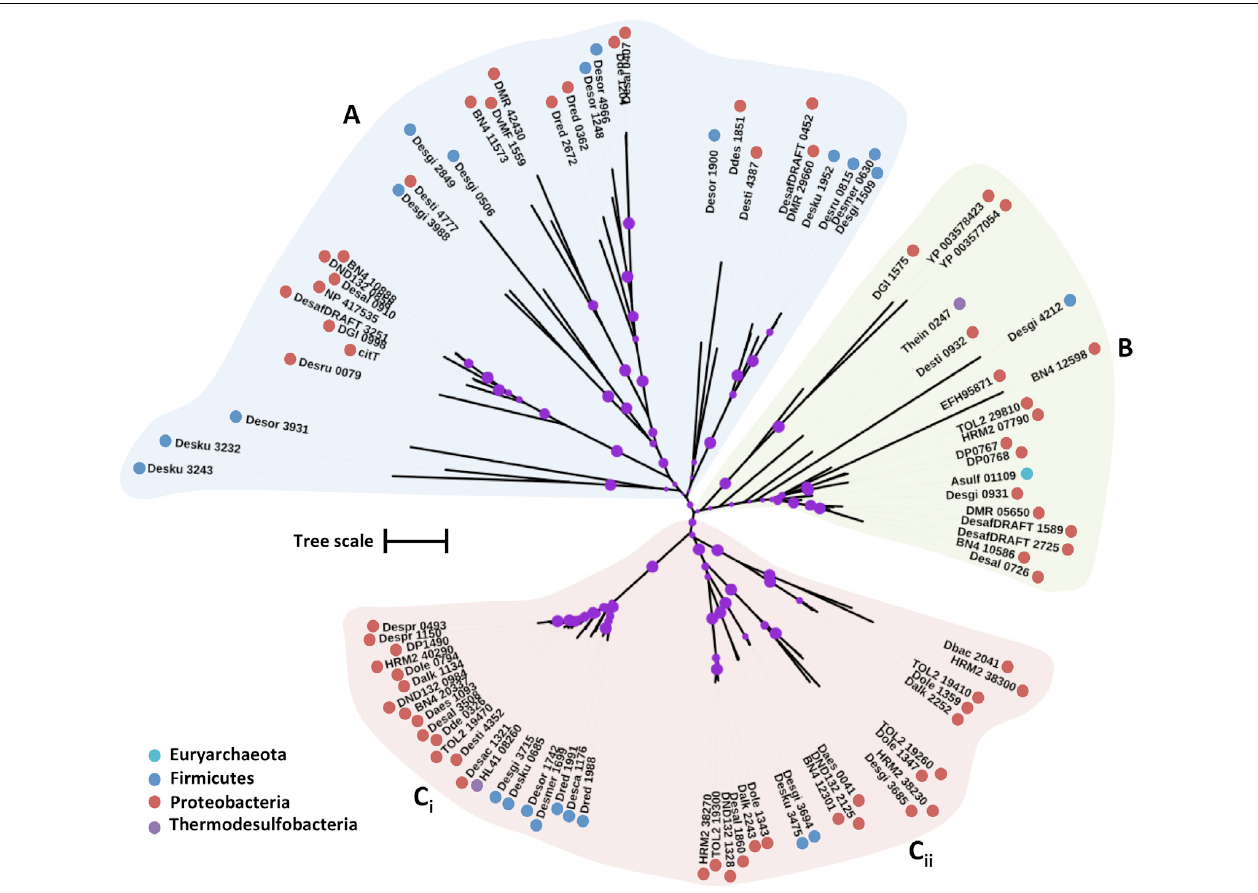
FIGURE 5 | Maximum likelihood phylogenetic tree of DASS protein sequences. The different protein clades are marked with different colored backgrounds and given a letter label (A–C) , while separate protein groupings are denoted by subscript numbering (i, ii, etc.). Phylum level classification of the protein sequences is indicated by colored dots next to the accession number (see Supplementary Table 1 for organism information). Reference sequences: citT, citrate/succinate antiporter (UniProt P0AE74), YP_003577054 (DASS sulfate transporter in R. capsulatus ), EFH95871 (SdcS, sodium-dependent dicarboxylate transporter), NP_417535 (ttdT, L -tartrate/succinate antiporter). Bootstrap values ≥ 50% are indicated by purple dots on each branch where the size of the dot is proportional to the value. The scale bar represents 1 substitution per amino acid